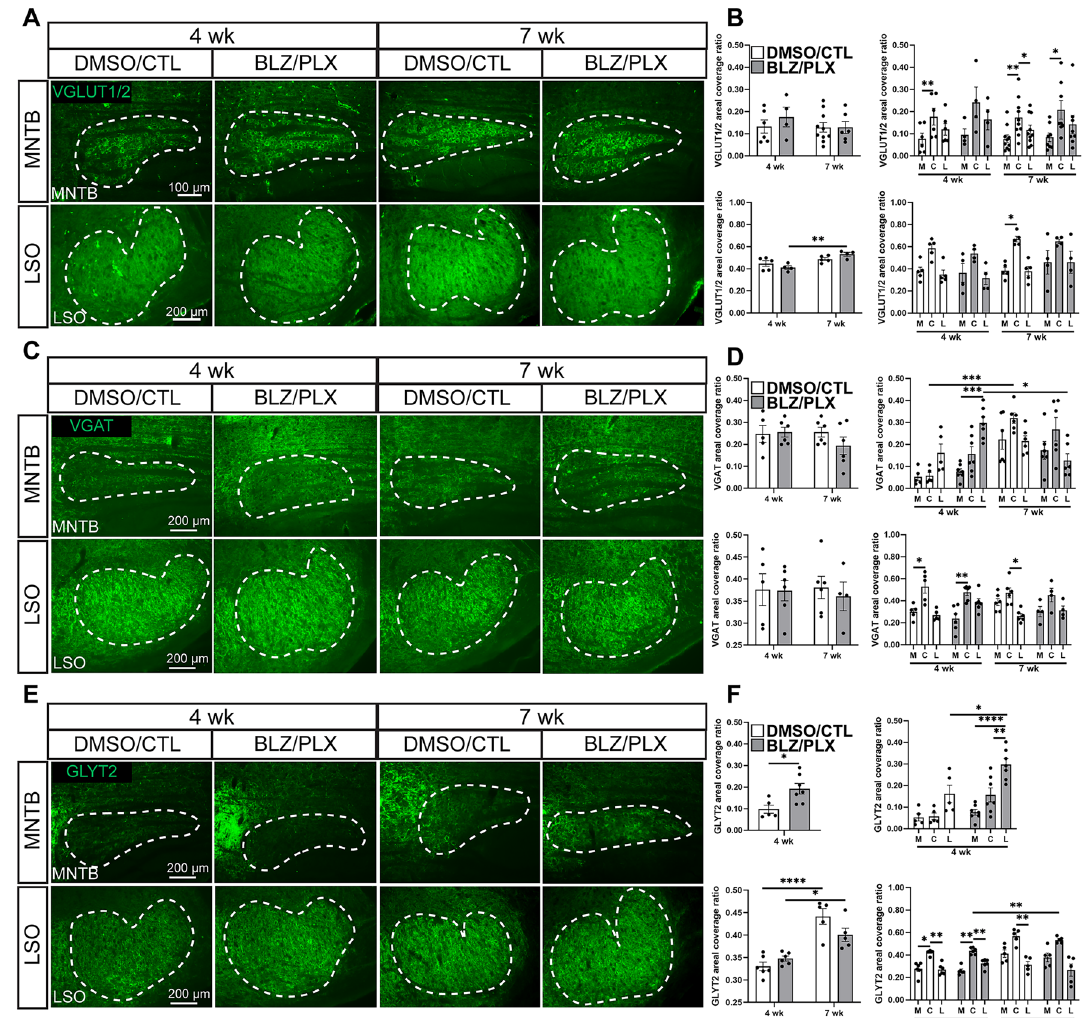
Figure 4. Inhibitory, but not excitatory, synaptic markers are elevated in microglia-depleted mice. ( A ) VGLUT1/2 immunolabeling (green) and their overlay in a control or treated mice at 4 and 7 wk. White dashed lines indicate MNTB or LSO. ( B ) Comparison of overall and regional VGLUT1/2 areal coverage in MNTB (above) or LSO (below) of 4 and 7 wk mice. VGLUT1/2 levels in MNTB were not altered from BLZ/PLX treatment. BLZ/PLX mice showed an increase in VGLUT1/2 levels with age. Increased VGLUT1/2 levels in central LSO were detected in the 7 wk DMSO/CTL group. ( C ) VGAT (green) immunolabeling and their overlay in control or treated mice at 4 or 7 wk. White dashed lines indicate MNTB or LSO. ( D ) comparison of overall or regional VGAT coverage in the MNTB (above) or LSO (below) of 4 and 7 wk mice. Overall VGAT levels in MNTB were not affected by microglia depletion but at 4 wk, BLZ/PLX treated mice showed higher VGAT expression in lateral MNTB. VGAT levels increased with age in both the control and treated groups. VGAT levels at 7 wk were higher in central MNTB in both DMSO/CTL and BLZ/PLX groups. There were no overall differences between age or treatment groups in the LSO and VGAT levels were elevated in central LSO at 4 wk in both control and treated groups. ( E ) GLYT2 (green) immunolabeling and their overlay in the MNTB or LSO of control or treated mice at 4 or 7 wk. White dashed lines indicate MNTB or LSO. ( F ) Comparison of GLYT2 areal coverage ratio in the MNTB of 4 7 wk mice. BLZ/PLX treated mice at 4 wk showed elevated GLYT2 levels. Lateral MNTB contained higher levels of GLYT2 in 4 wk BLZ/PLX mice. In the LSO, GLYT2 levels increased with age in both control and treated groups. GLYT2 was elevated in the central LSO in control and treated groups at 4 wk. * p <